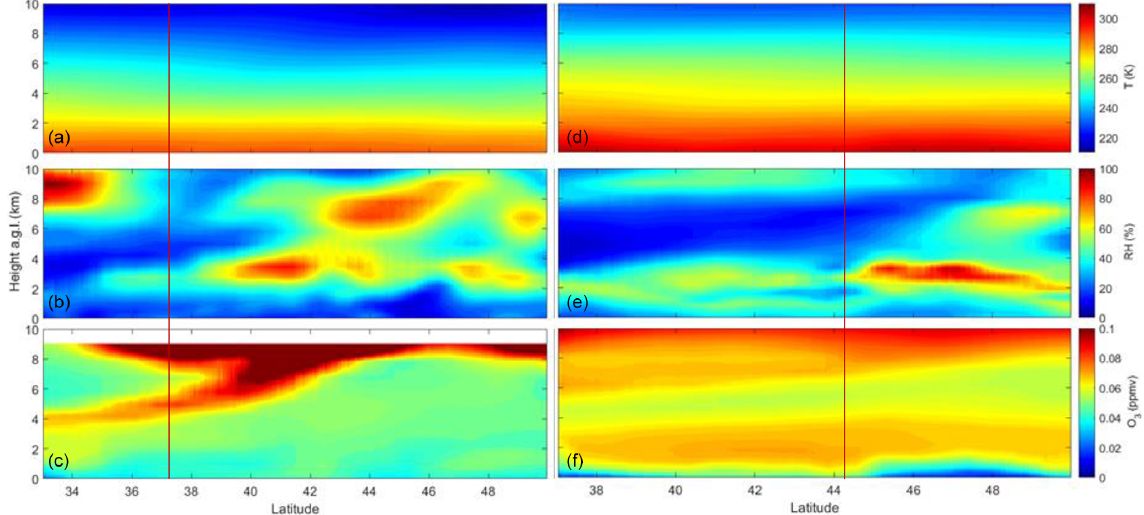
Figure 2. ERA-Interim temperature ( T ; a, d ), relative humidity (RH; b, e ) and ozone (O 3 ; c, f ) profiles for 7 April 2011 (GR) and 4 July 2012 (BU). The vertical red lines indicate the position of the Granada (a, b, c) and Bucharest (d, e, f) EARLINET